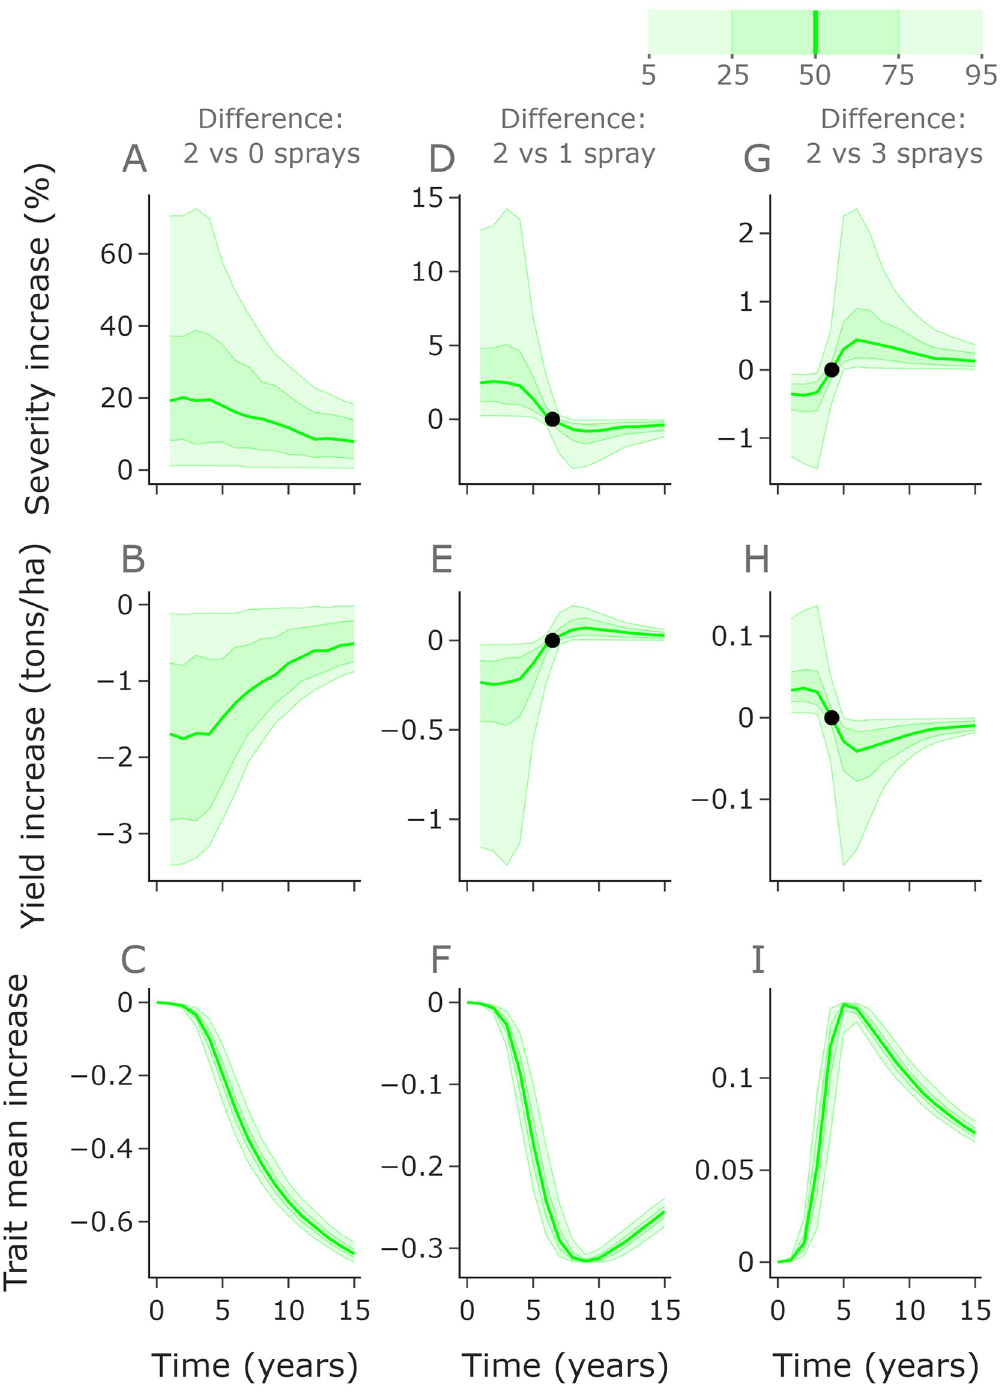
Fig 4. The optimal disease management strategy depends on the relevant timeframe. In the left, middle and right columns we compare the performance of zero, one and three fungicide applications annually with the performance of two applications annually. Zero applications (no control) leads to higher severity ( A ) and lower yield ( B ) than two applications, although the difference reduces over time due to selection for resistant strains ( C ). Initially one application leads to increased severity ( D ) and decreased yield ( E ), but by year 7 one application is better than two due to reduced selection for resistant strains ( F ). Conversely, three fungicide applications initially leads to lower severity ( G ) and higher yield ( H ), but by year 5 this benefit is lost due to increased resistance ( I ). The black dots (panels D , E , G , H )denote when the median line crosses 0, i.e. when severity/ yield changes so that 1 spray outperforms 2 / 2 sprays outperform 3. Here n k = 400.